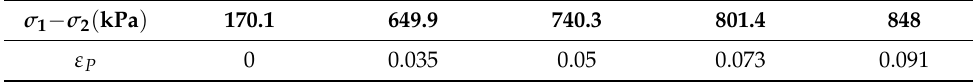
Table 4. Hardening parameters of Drucker–Prager